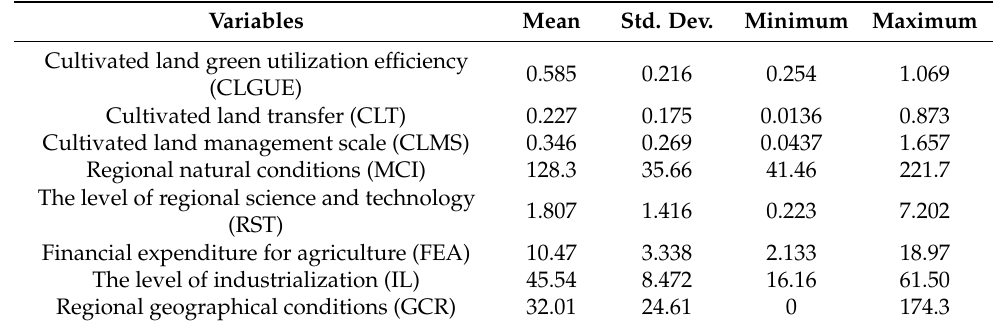
Table 2. Descriptive Statistics of